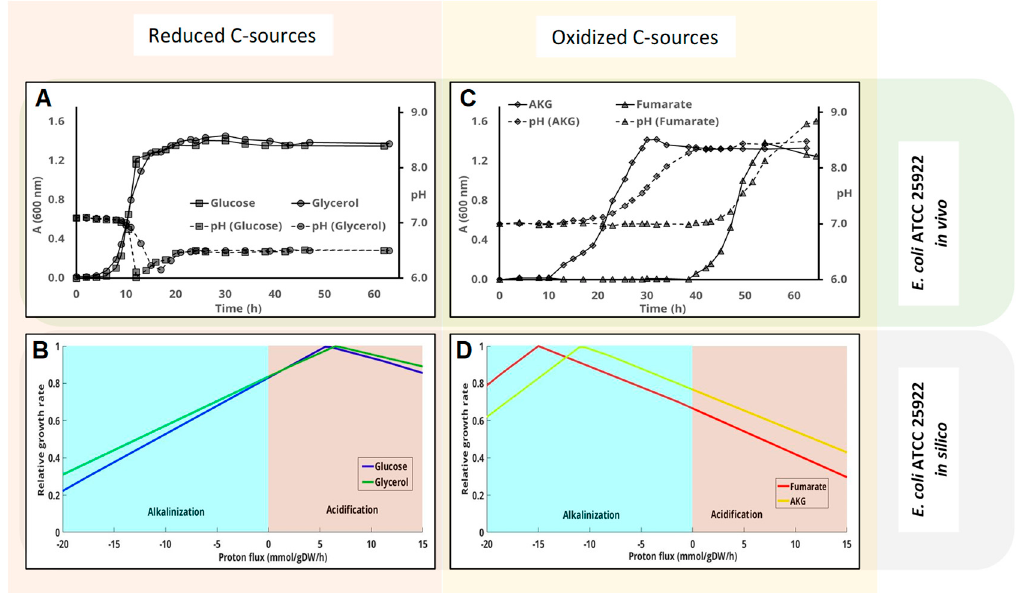
Figure 2. Influence of the carbon source on the pH change in E. coli ATCC 25,922 cultures. Cells were inoculated in M63 media containing different carbon sources. Cell-growth (solid lines-A(600 nm)) and pH change (dashed lines) were measured at the indicated times. Glucose and glycerol, which are considered reduced carbon sources, are plotted together (panel ( A )), whereas panel ( C ) shows the results obtained using the more oxidized carbon source fumarate and 2-oxoglutarate. Panels ( B , D ) represent the predicted influence of proton flux (negative implies uptake and therefore alkalinilization of the medium) on the growth rate using the genome scale metabolic model of this strain as indicated in the Materials and methods section.